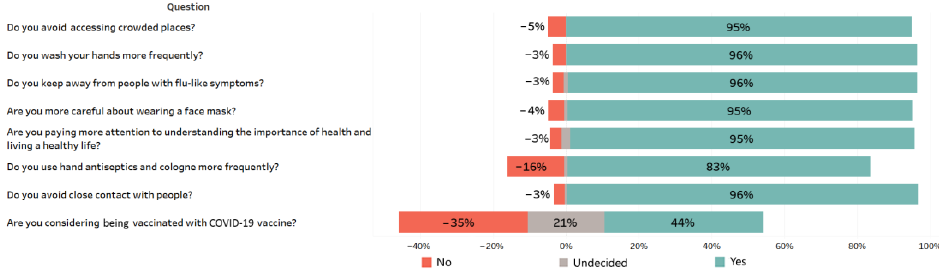
Figure 4. Practices of the participants toward COVID-19 ( n = 664). Table 4. The relationship between approach of the participants towards vaccination from COVID-19 vaccines and demographic parameters.